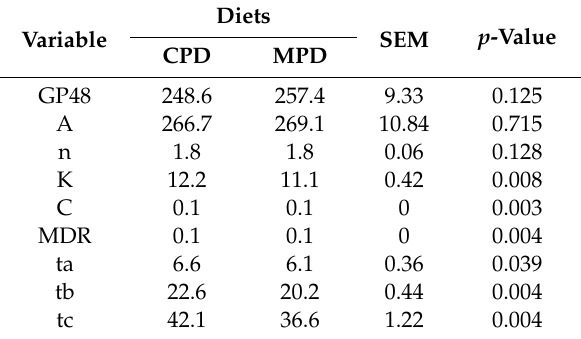
Table 5. Least square means of the parameters of the in vitro gas production kinetics of diets. Variable